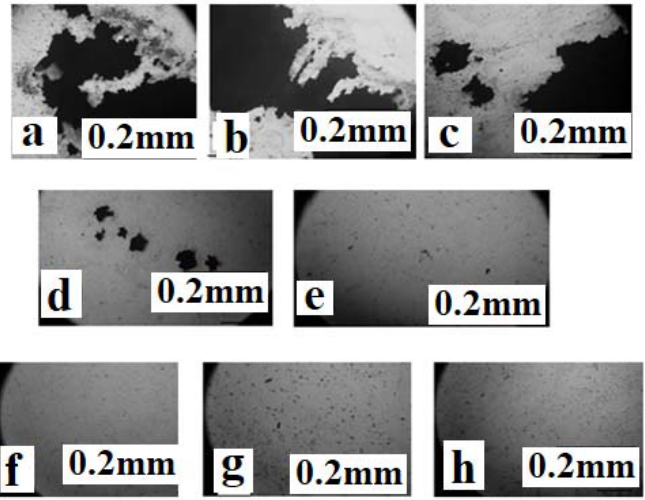
Fig. 19. Microscopic images of aging samples during different aging times ;(a) 1hr, (b) 5hr, (c) 10hr, (d) 15hr, (e) 20hr: immersion test where (a, b, c, d, e) at 500 °C and (f, g, h, i, k ) at 650